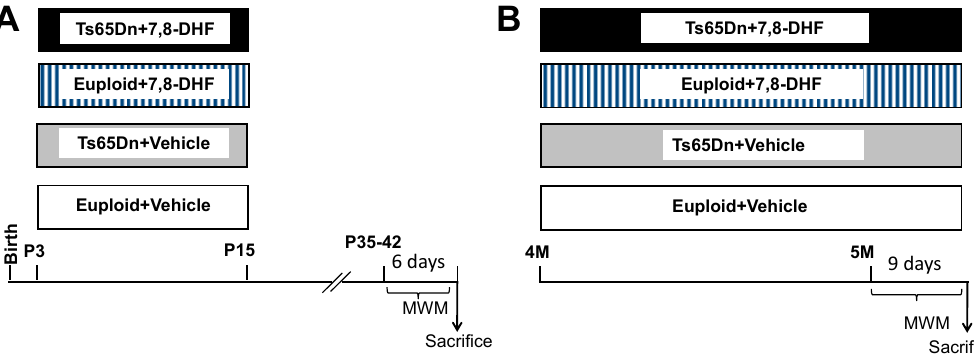
Figure 1. Experimental protocol. ( A ): Euploid and Ts65Dn mice were daily injected with either vehicle (Eu + Vehicle; Ts65Dn + Vehicle) or 5.0 mg/kg of 7,8-DHF (Eu + 7,8-DHF; Ts65Dn + 7,8-DHF) from P3 to P15. Starting from the age of 35-42 days, mice were behaviorally tested with the MWM for 6 days. ( B ): Euploid and Ts65Dn mice were daily injected with either vehicle (Eu + Vehicle; Ts65Dn + Vehicle) or 5.0 mg/kg of 7,8-DHF (Eu + 7,8-DHF; Ts65Dn + 7,8-DHF) starting from 4 months of age. At the age of 5 months mice were behaviorally tested with the MWM for 9 days. Treatment was continued during behavioral testing. Abbreviations: 7,8-DHF, 7,8-dihydroxyflavone; M, months; MWM; Morris Water Maze; P, postnatal.